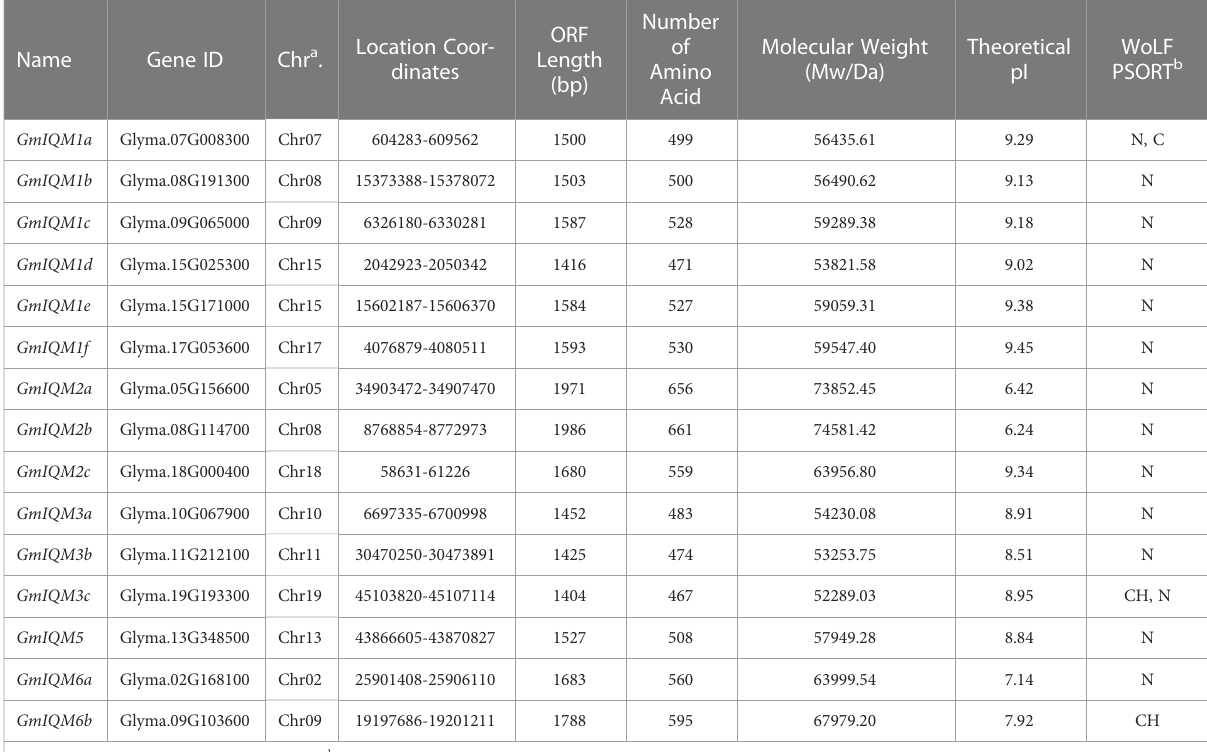
TABLE 1 List of characteristics of 15 soybean IQM genes.